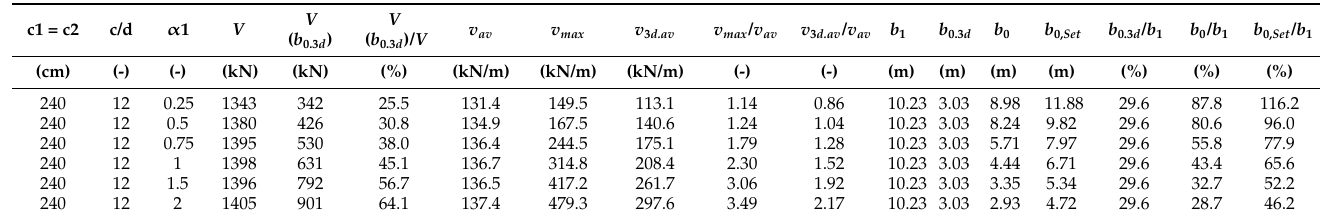
Table A9. Analysis of the shear force distribution in the control perimeter 0.5 d with 240 cm shear cap size.